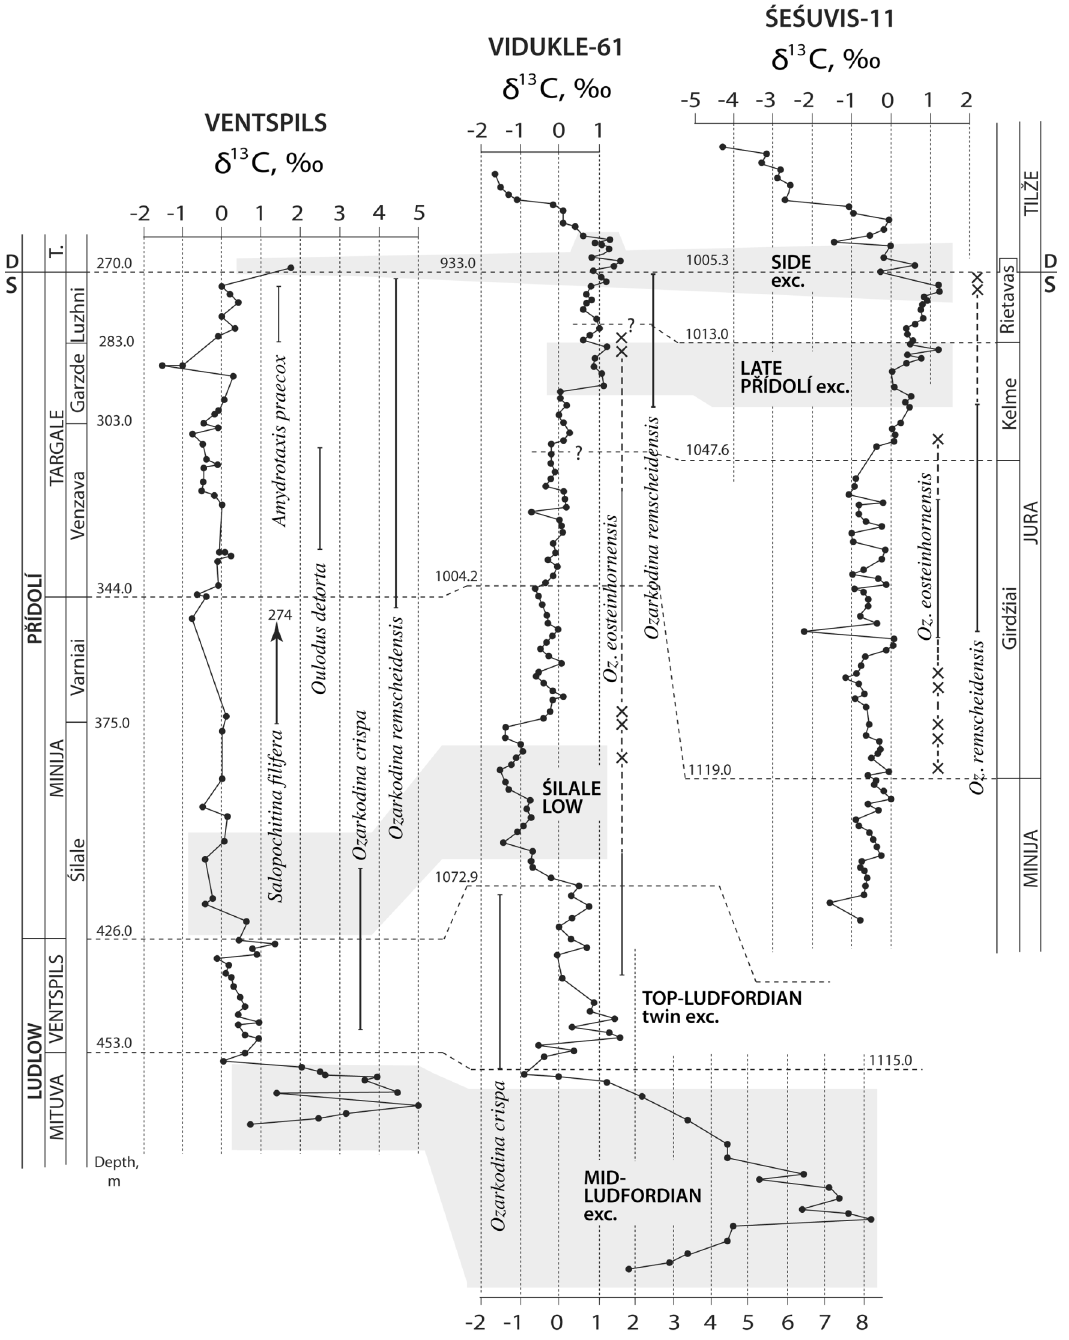
Fig. 6. Correlation of the Vidukle, (cid:138)e(cid:154)uvis and Ventspils δ 13 C curves between the mid-Ludfordian and the Silurian(cid:150)Devonian boundary (SIDE) excursions. Conodont information in Vidukle and (cid:138)e(cid:154)uvis is from Brazauskas (1993) and in Ventspils from Viira (1999, 2000). Note that binary nomenclature is used for economy of space. Chitinozoan data from Nestor (2011). The steady line shows continual occurrences, the broken line with x (cid:150) single occurrences. Number 274 in the Ventspils part means that S. filifera continues up to this